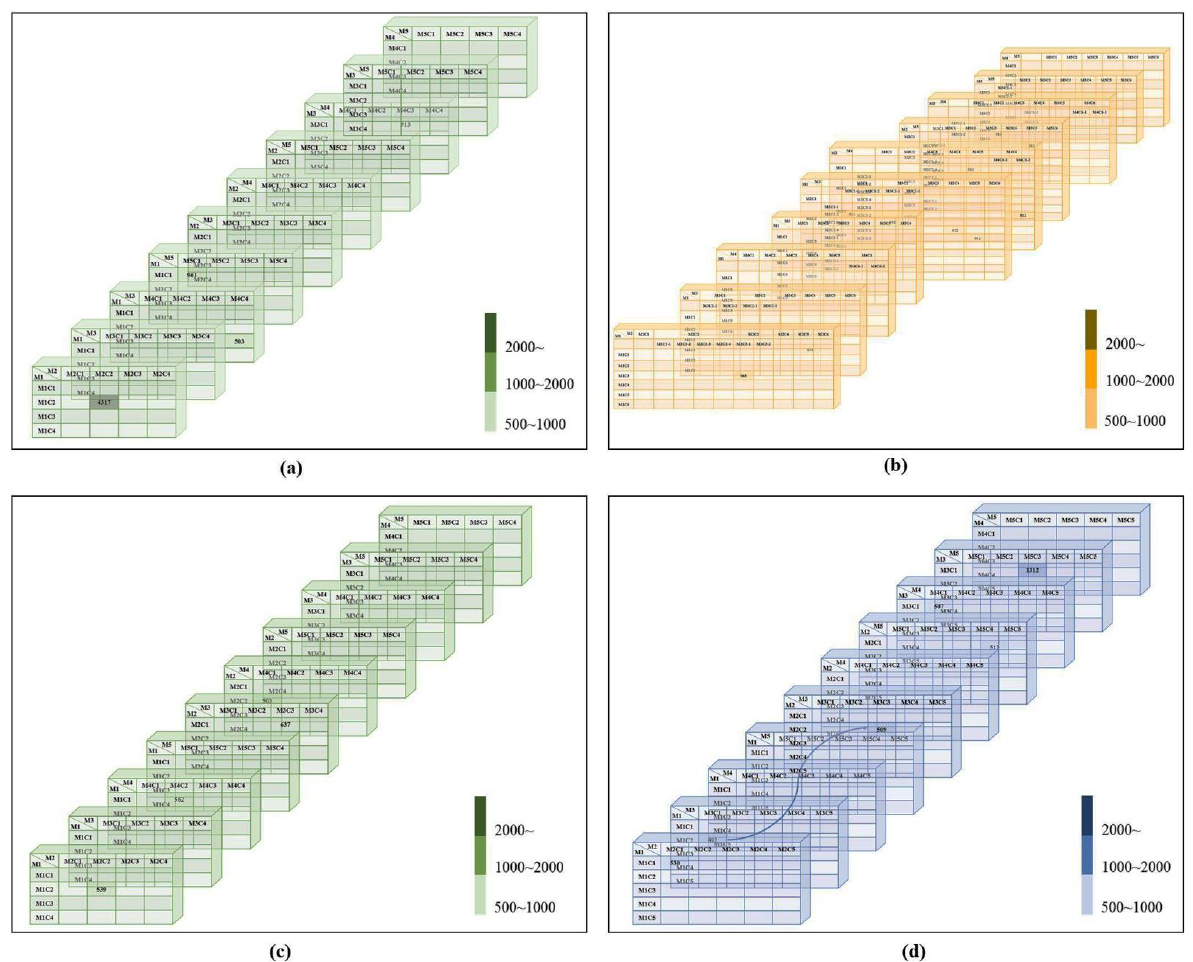
Figure 4. Periclinal wall results. Marginal verrucae — ( a ) four-grayscale clusters result, ( b ) six-grayscale clusters result, Small verrucae — ( c ) four-grayscale clusters result, ( d ) five-colored clusters result.